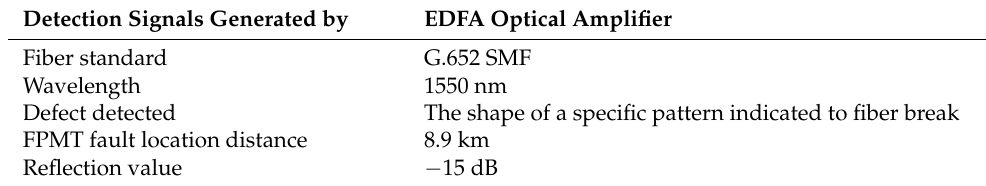
Table 5. The parameters and practical results detected at event 1.